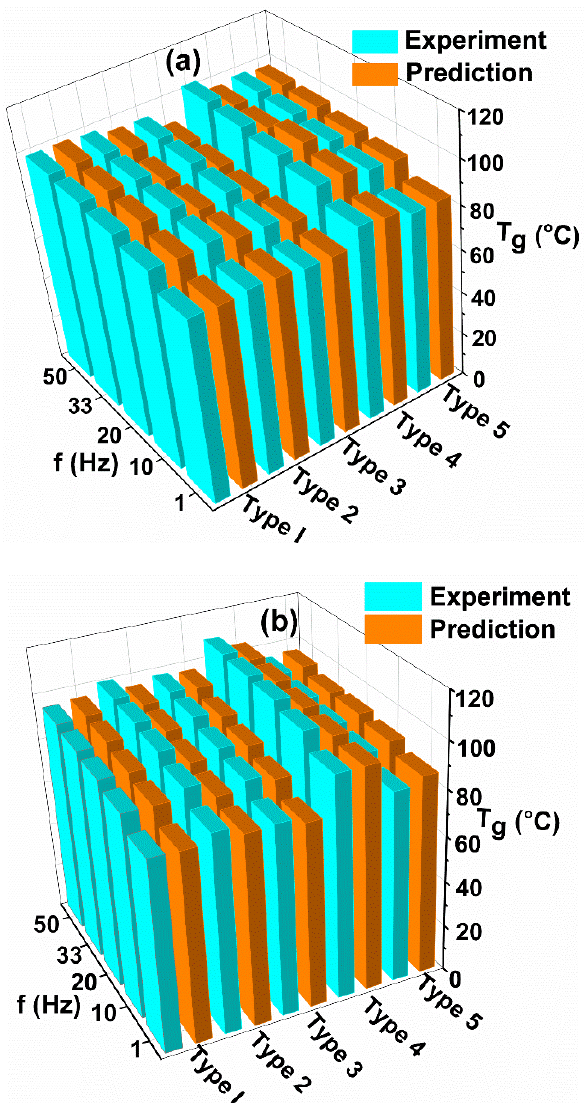
Figure 15. Comparisons of predicted T g [(tan δ ) max ] values with experimental results for di ff erent types and frequencies of GFRP ( a ) and CFRP ( b ) composites.